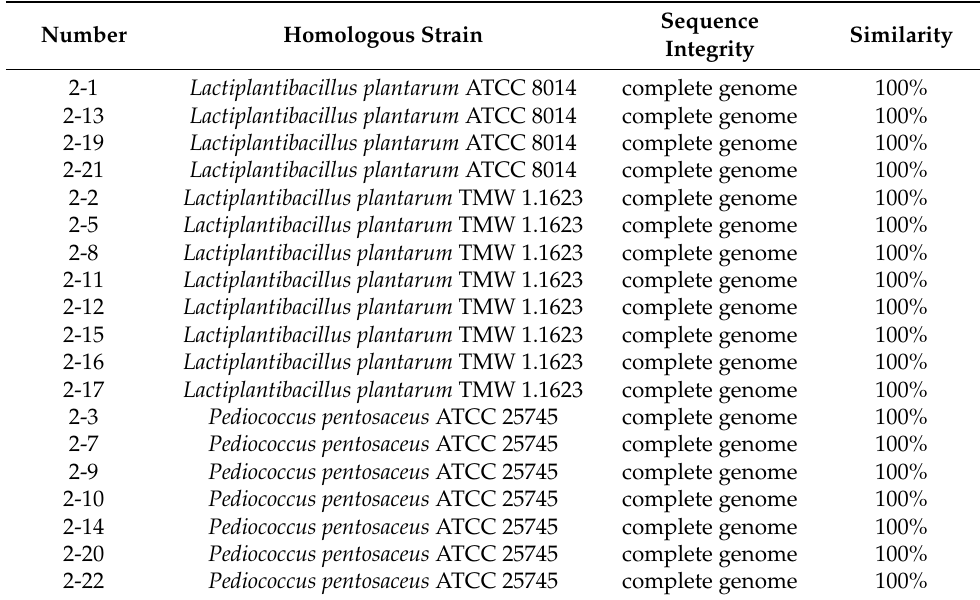
Table 4. Homology analysis of LAB strains in Gansu